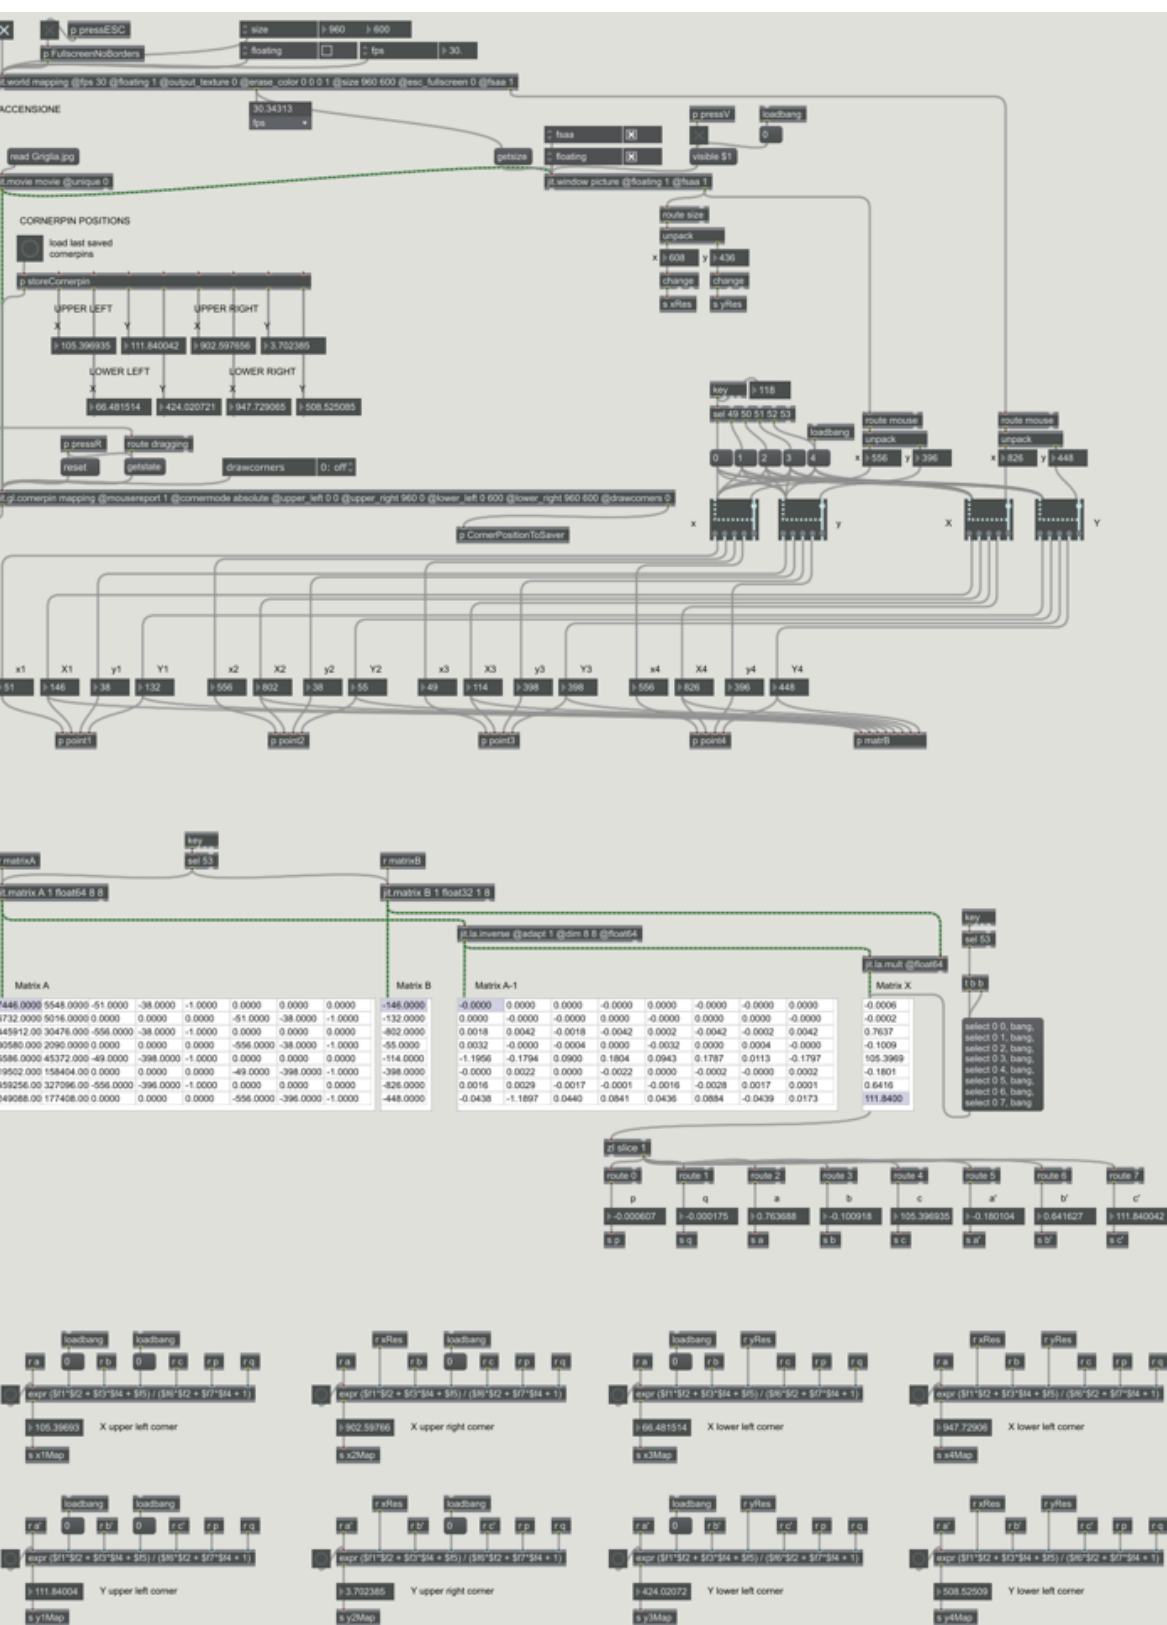
Figure 4. Screenshot of the automatic warping